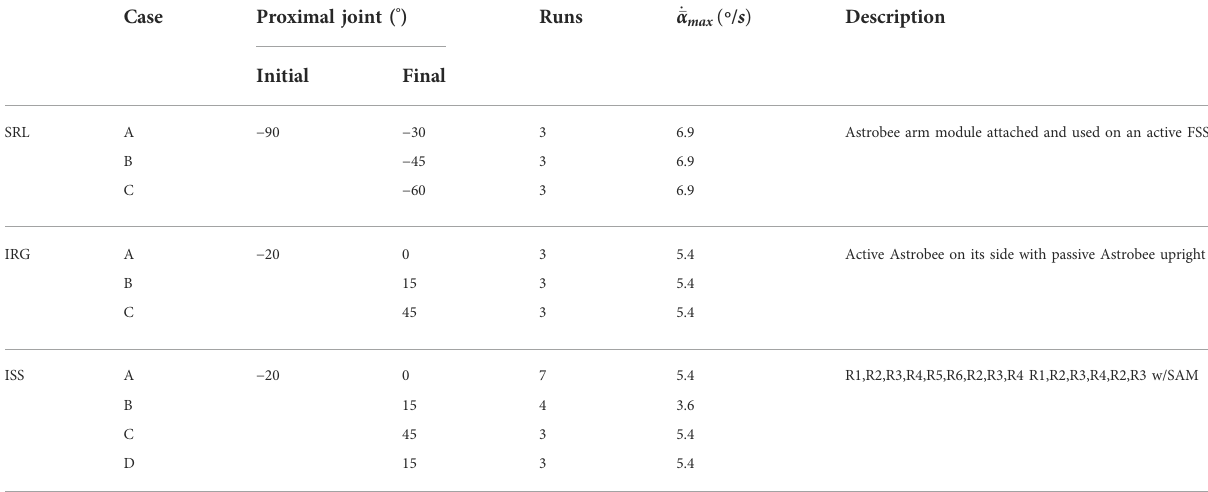
TABLE 1 Hopping maneuvers performed at SRL, IRG, and aboard the